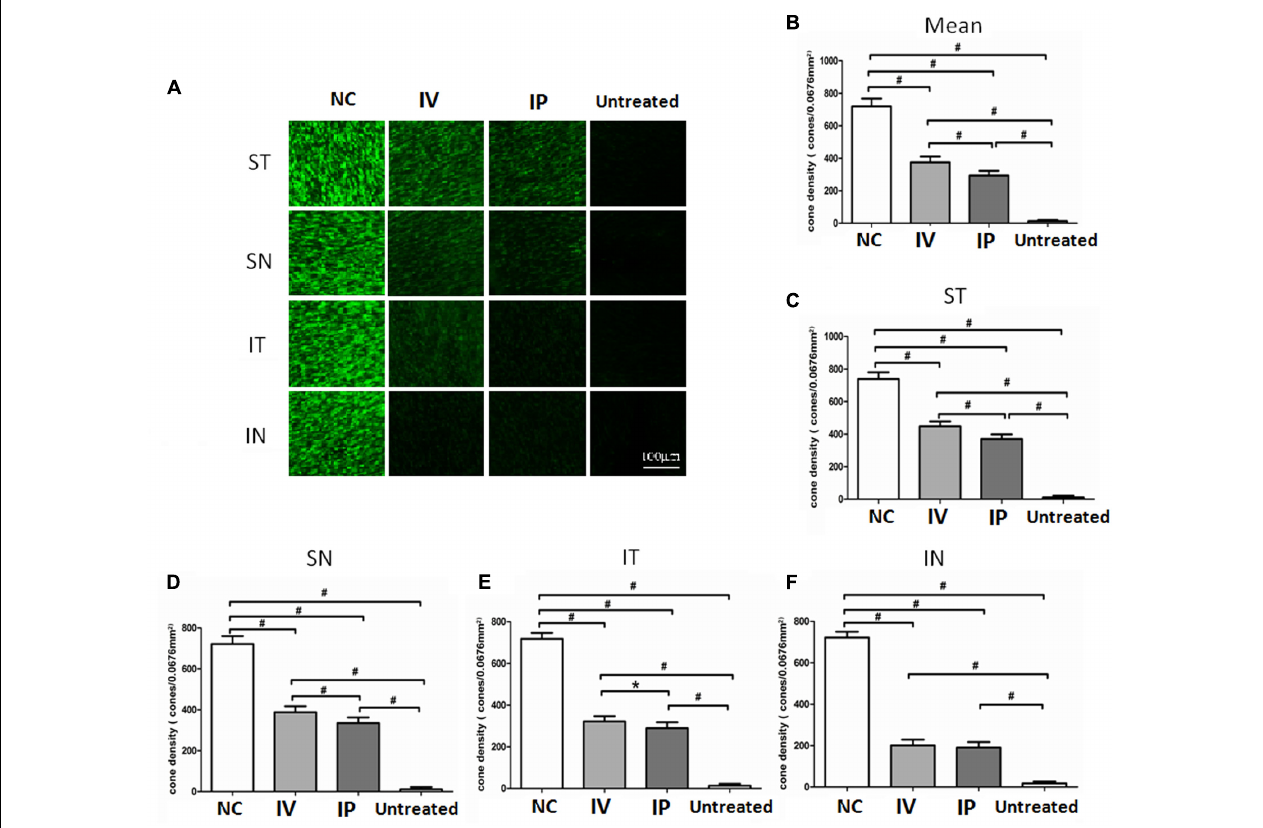
FIGURE 5 | Topographic effects of IV and IP injections on cone photoreceptors. (A) The PNA immunostaining of regional cone photoreceptors in the retinal wholemounts. (B) The cone density of untreated group was significantly smaller than the normal controls ( P < 0.01). The cone densities of both IV and IP treated groups were significantly larger than the untreated group ( P < 0.01). The mean cone density of the IP treated group was significantly smaller than the IV treated group ( P < 0.01; n = 10). (C–F) In both IV and IP treated groups, the cone density of the ST quadrant was significantly larger than the other three quadrants ( P < 0.01). The cone density of the IV treated group was significantly larger than the IP treated group respectively in the ST, SN, and IT quadrant. In the IN quadrant, the cone density of the IV treated group was not significantly different from the IP treated group ( P > 0.05; n = 10). (All the values were presented as mean ± SD; ∗ P < 0.05, # P < 0.01 for differences compared between the animal